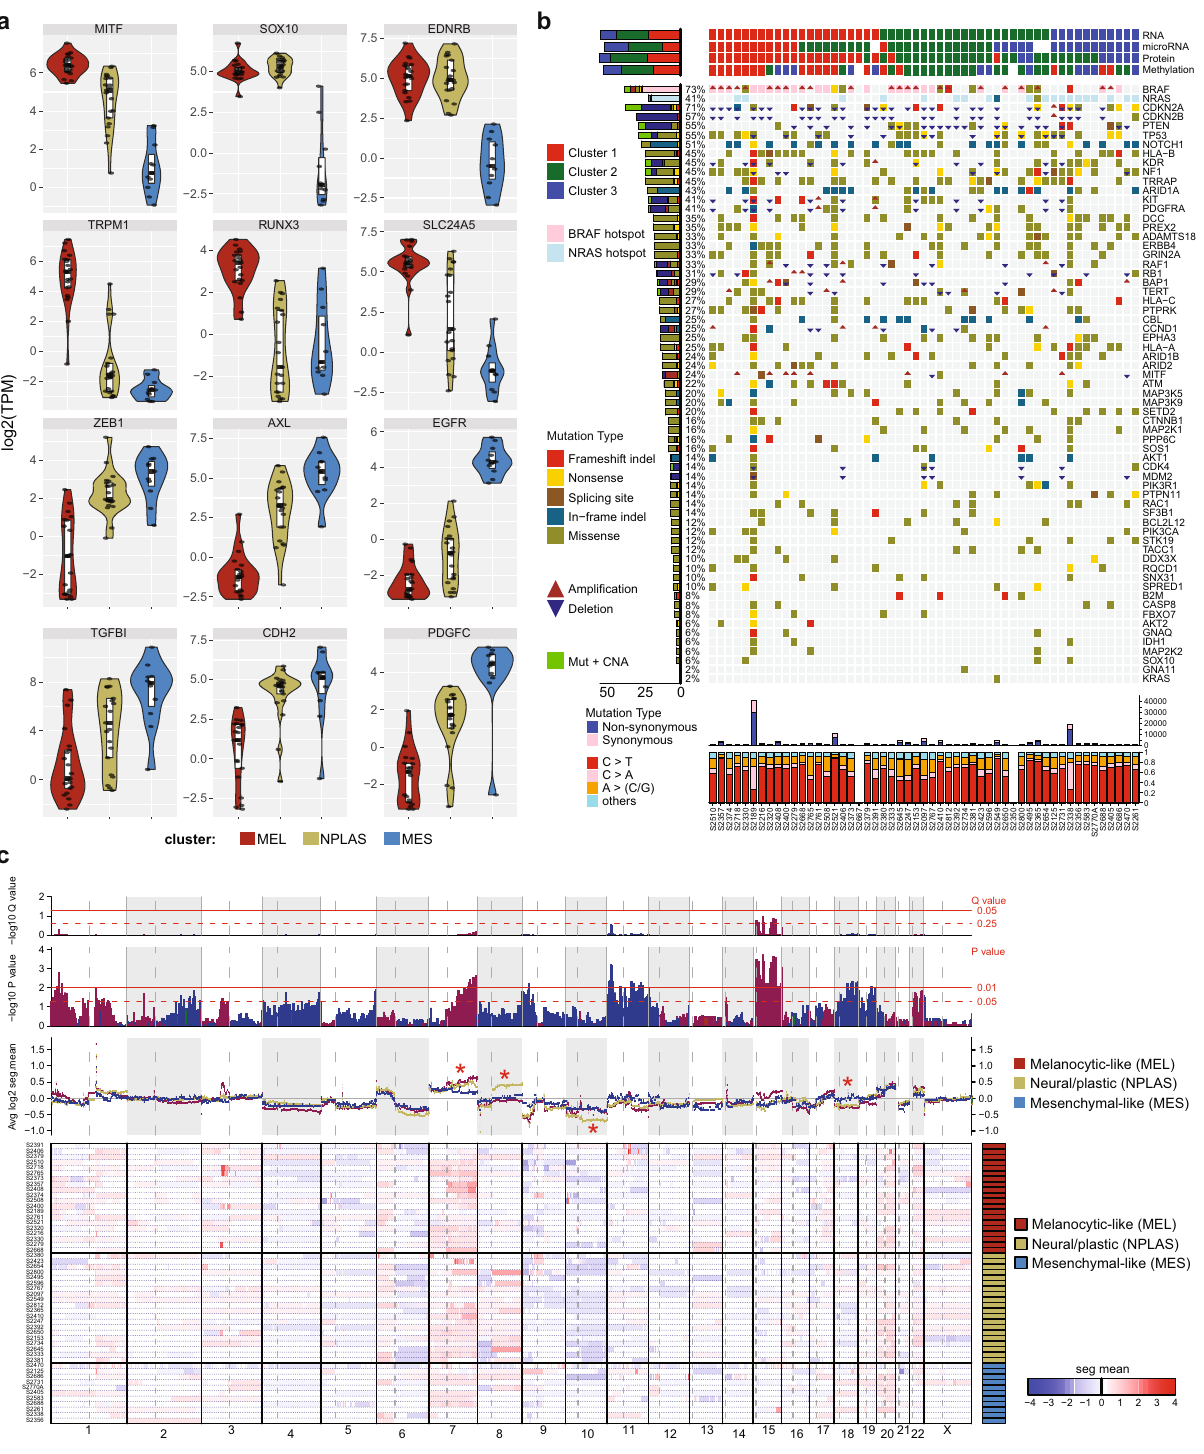
located within an intron of the TRPM1 gene, a member of the MEL gene set. The coordinated upregulation of TRPM1 and miR- 211-5p in MEL samples was consistent with a shared transcrip- tional regulation, which in the case of miR-211-5p, reinforces MEL gene set expression due to miR targeting of several MES genes including EPHB2 , THSD4 (thrombospondin type I domain containing 4), NUAK1 (cancer-promoting driver of EMT) 55 , KCNMA1 (cancer invasion and metastasis) 56 , and ZEB1 (a key driver of EMT-like processes in melanoma) 7 . Indeed, miR-211 NATURE COMMUNICATIONS| (2022) 13:4000